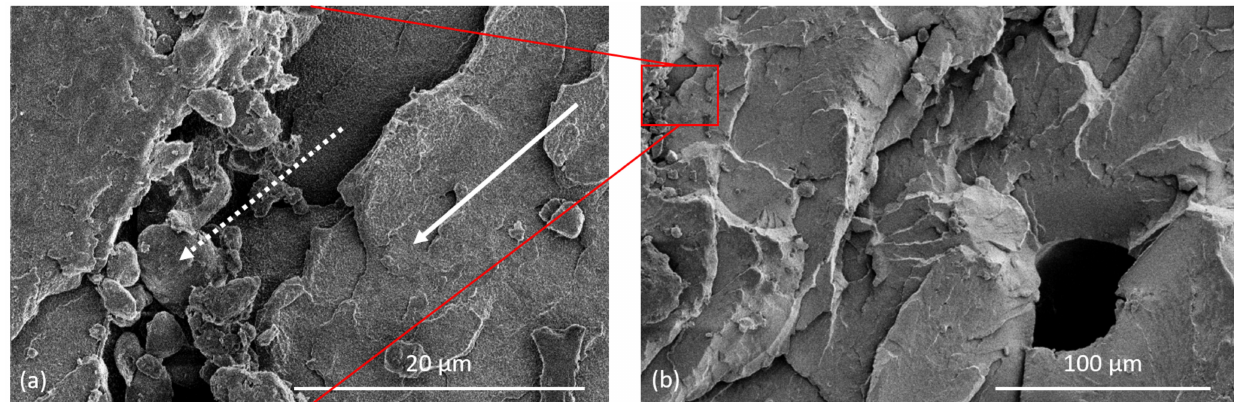
Figure 14. SEM pictures ( a ) of the fractured surface of a tensile specimen showing sintered regions (arrow) and unmelted particles (dotted arrow); ( b ) void comparable in size to the powder particle. The picture in ( a ) is an expansion of the rectangle area in ( b